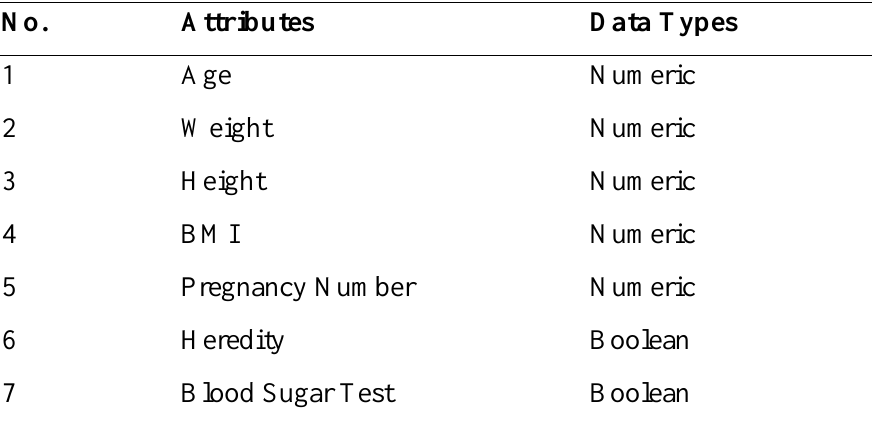
Table 1 . The Attributes and Data Types of Training